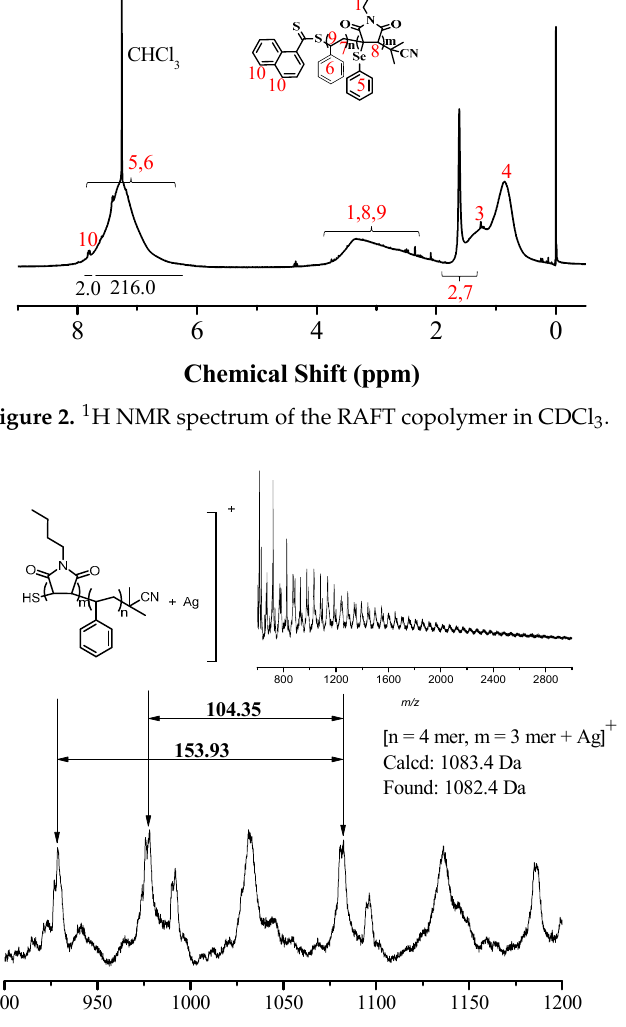
Figure 3. Expanded MALDI-TOF mass spectrum of the RAFT copolymer by using Ag salt as the cationization agent and a DCTB matrix.